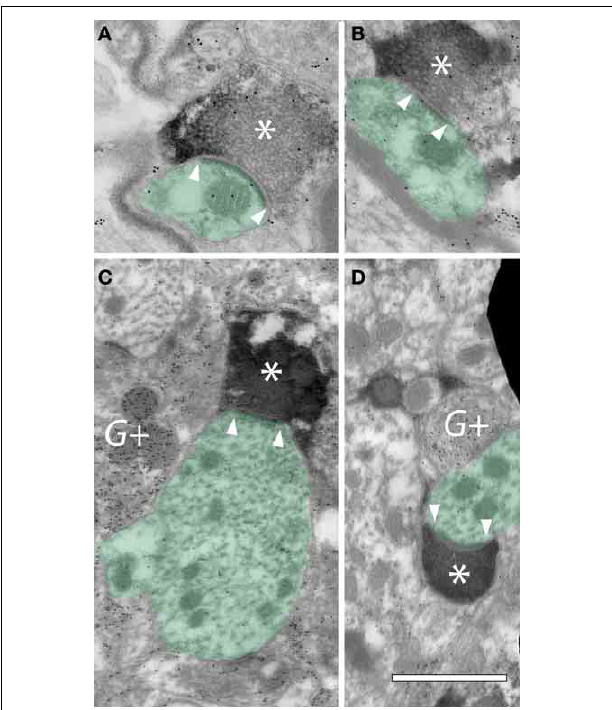
FIGURE 5 | Electron micrographs showing FR-labeled cortical boutons forming synapses in the ipsilateral nucleus of the brachium of the inferior colliculus (NBIC). (A–D) Cortical boutons ( ∗ ) are filled with DAB precipitate resulting from transport of FluoroRuby. Internal structures in the boutons were obscured by the DAB precipitate, but round synaptic vesicles could often appear negatively stained within the profiles. Postsynaptic densities were typically prominent (located between the white arrowheads). The postsynaptic targets of these cortical boutons were dendrites (green shading). Post-embedding immunogold staining was used to identify GABAergic profiles, indicated by gold particles (small black dots) (G + ). GP363. Scale bar = 1 µ